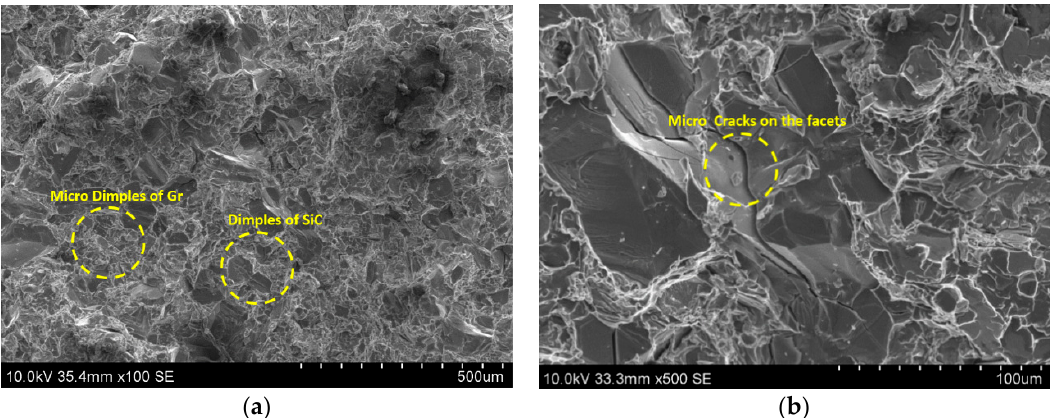
Figure 10. SEM photomicrographs of HAMCs ( a ) showing many dimples of particulates and fewer tear ridges and ( b ) cleavage facets and micro-cracks.